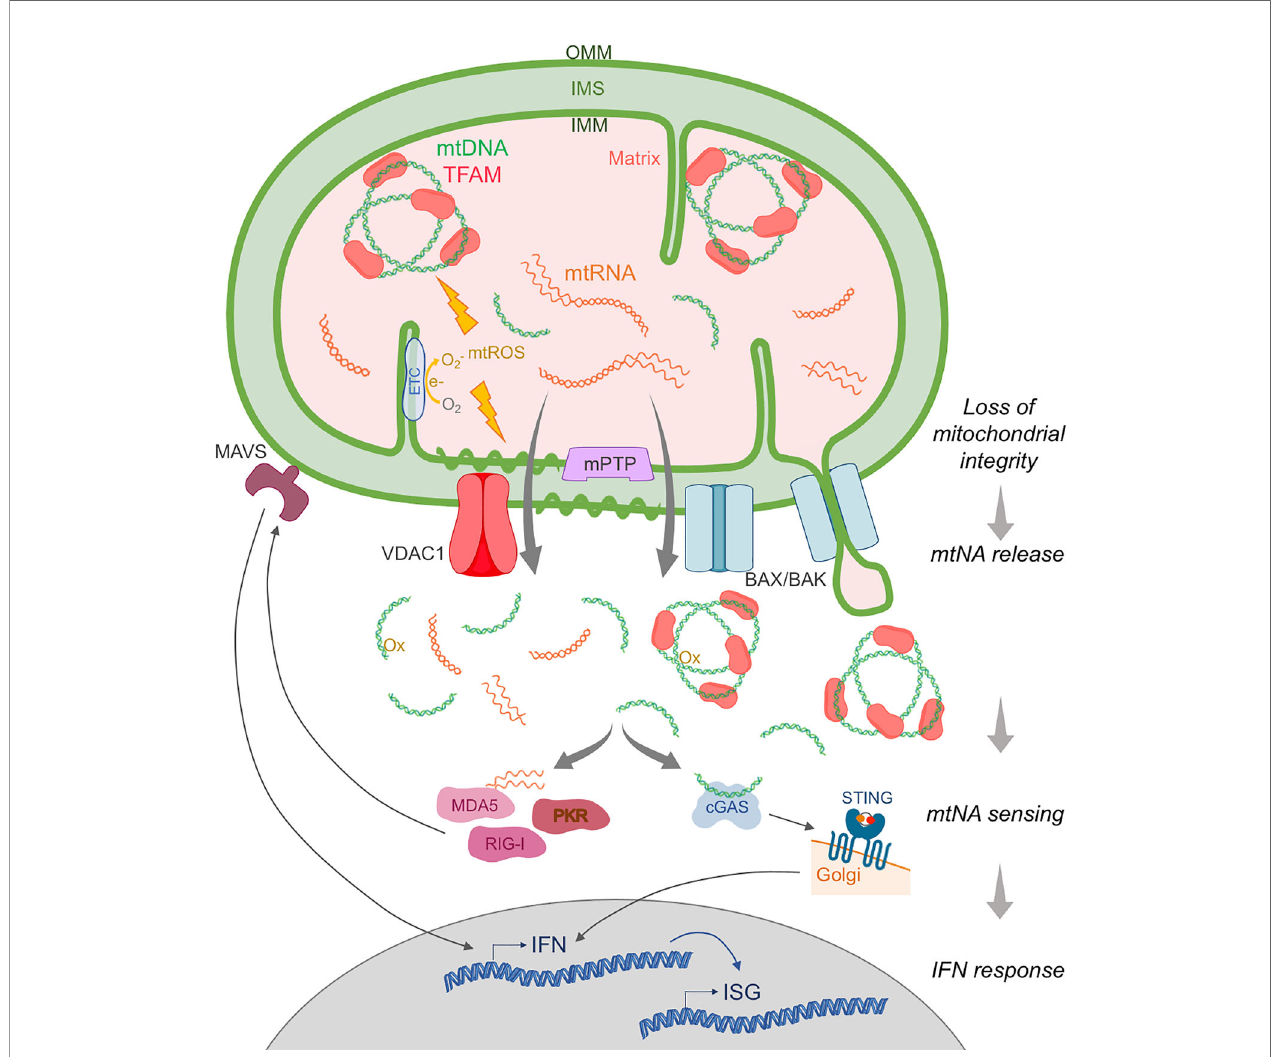
FIGURE 1 | Main pathways of mitochondrial nucleic acid release and sensing. Upon extrinsic or intrinsic insult, the mitochondrial membrane integrity is compromised and mtDNA and mtRNA, normally contained within the double membrane, can be released into the cytosol. Release of mtDNA packaged into nucleoids by TFAM is mediated by outer mitochondrial membrane (OMM) perforation by BAX/BAK macropores, while mtDNA fragments devoid of TFAM are thought to egress through VDAC1 pores. Inner mitochondrial membrane (IMM) permeabilization to mtNA can involve herniation into BAX/BAK pores, destabilization due to oxidative stress (e.g. mitochondrial ROS (mtROS) generated from electrons (e_) leaking from the electron transport chain (ETC)), and/or opening of the mitochondrial permeability transition pore (mPTP). In the cytosol, mtDNA, oxidized (Ox) mtDNA and mtRNA are detected as foreign by innate cytosolic sensors of immunostimulatory DNA (e.g. cGAS), and RNA (e.g. RIG-I, MDA5, PKR). These receptors then activate the adaptor molecules STING and MAVS, respectively, leading to the induction of IFN and subsequent IFN-stimulated gene (ISG) expression. IMS, inner membrane